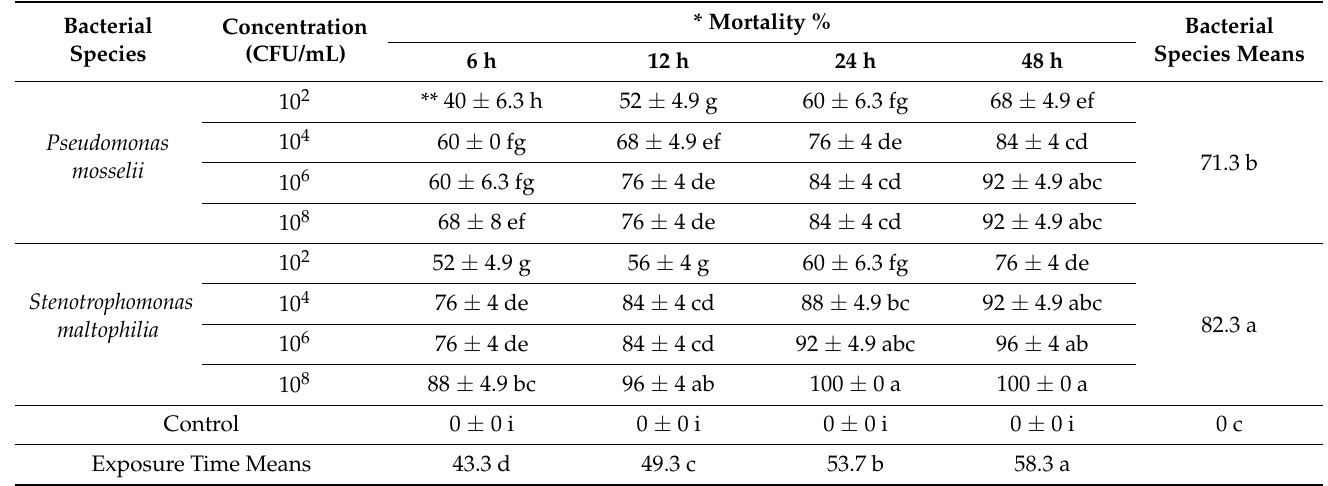
Table 7. Larvicidal activity of two bacterial species cells on the carob moth, Ectomyelois ceratoniae , under laboratory conditions.